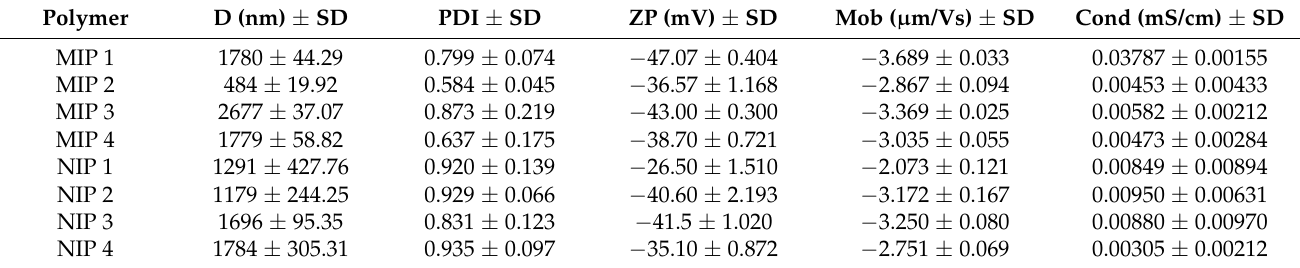
Table 3. Particle characteristics determined by DLS.